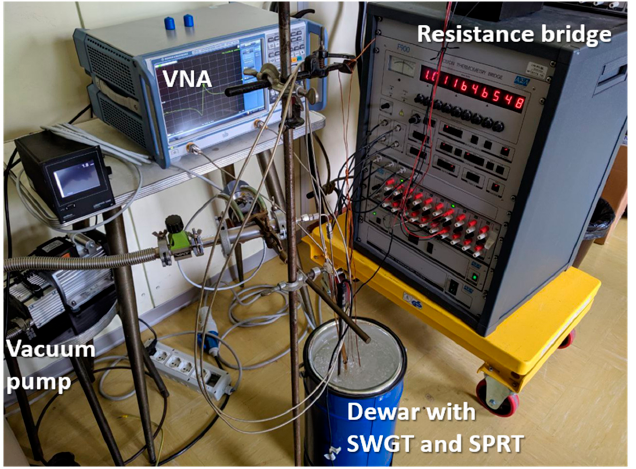
Figure 12. Measurement setup for the ice melting point stability test: SWGT inside the Dewar flask with the SPRT. They are connected to the VNA and the resistance bridge, respectively.